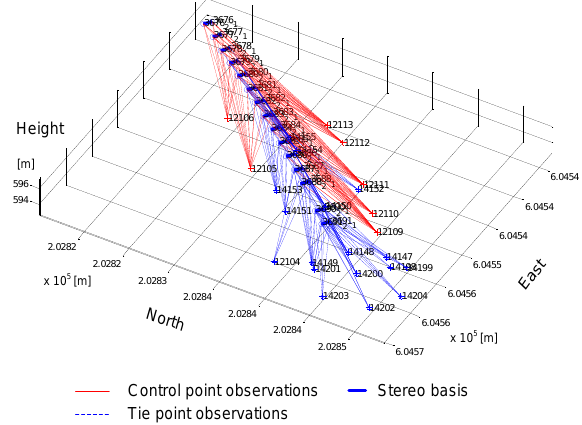
Figure 3. Stereo bundle adjustment network geometry with integrated relative orientation